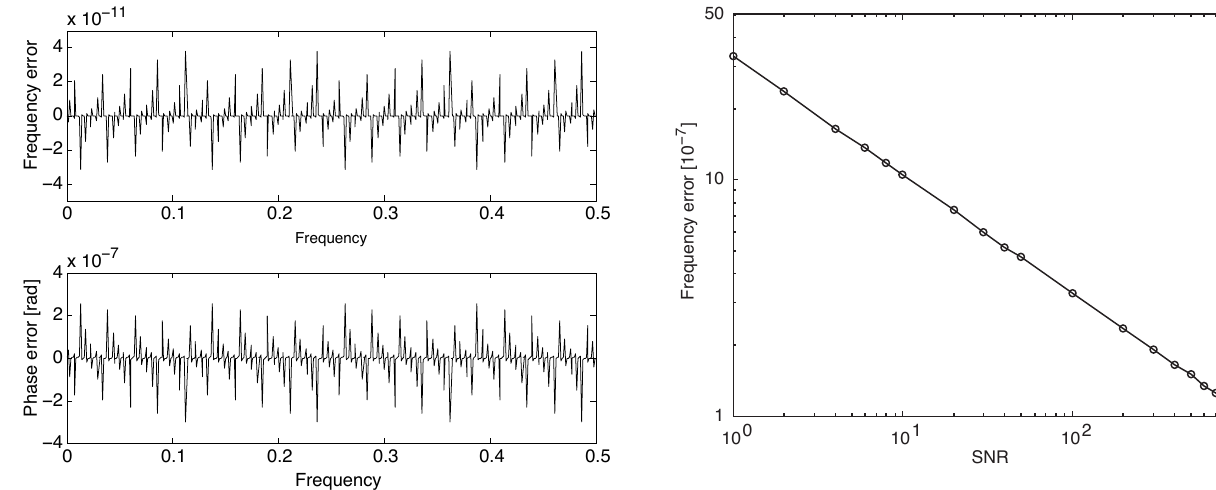
Fig. B1. The errors (standard deviations) of frequency determina- tion as a function of SNR. The pulse frequency is 0.01 and the pulse length is 1920 samples before padding with zeros up to a length of 2 13